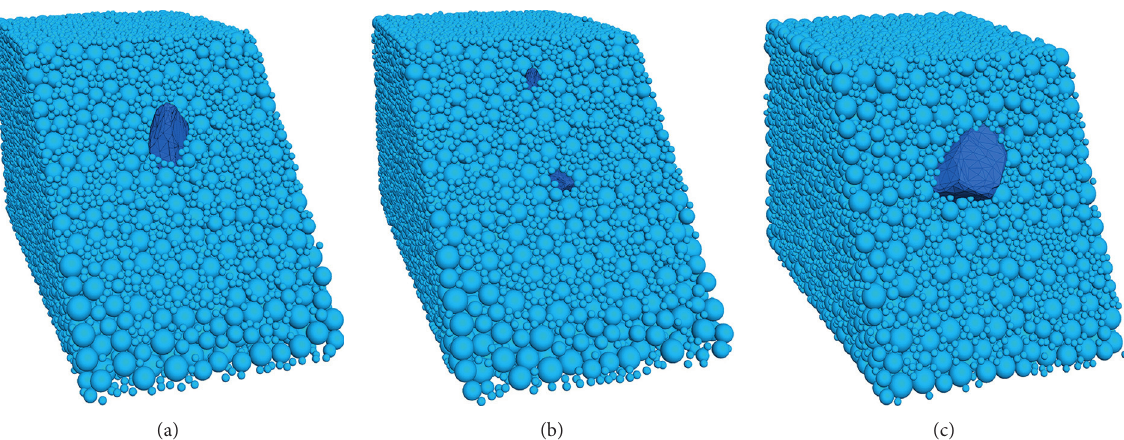
Figure 15: Layout of Clump blocks. (a) 45-L, (b) 45-SM, and (c) 60-L. 45-L, 45-SM, and 60-L mean slope with 45 ° gradient and large block, slope with 45 ° gradient and small and medium block, and slope with 60 ° gradient and large block,